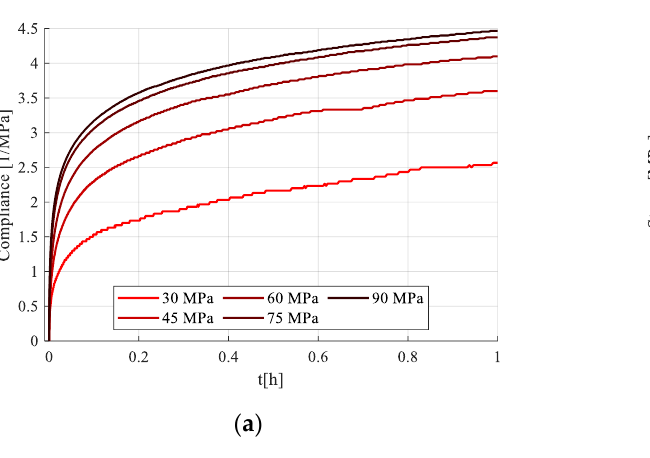
Figure 15. Creep-recovery tests analysis: ( a ) compliance curves of the creep phases; ( b ) isochronous curves. Data recorded for strain during loading and during creep is extracted in Table 5.